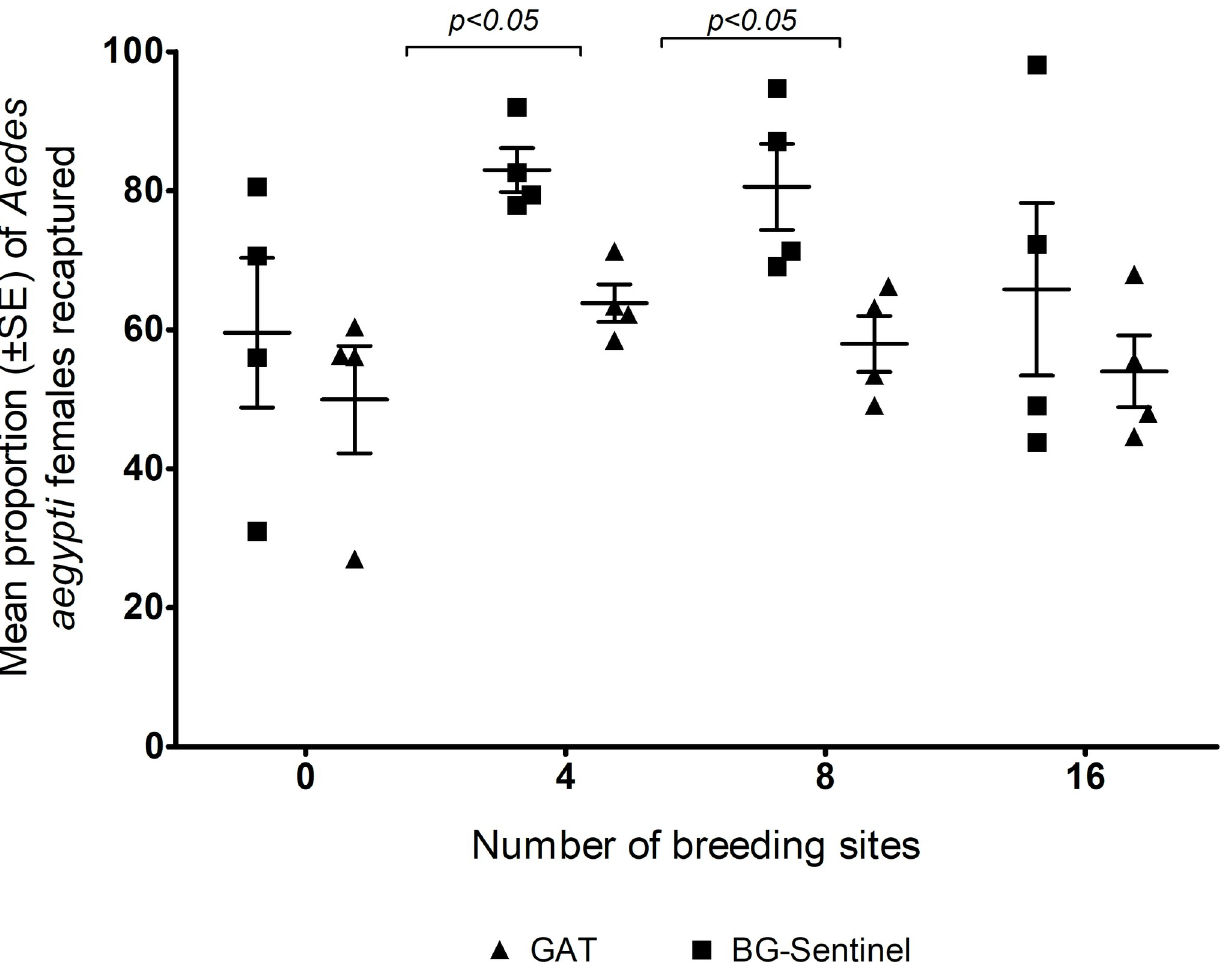
Fig 2. Mean percentage ( ± SE) of Aedes aegypti females recaptured by the BG-Sentinel trap (A) or by the Gravid Aedes Trap (B) and the comparison between both traps (C) in a simulated outdoor environment with 0, 4, 8 or 16 breeding sites per environment. Horizontal lines on Panel C show the significant difference for the GAT and the BGS in experiments with 4 and 8 breeding sites per